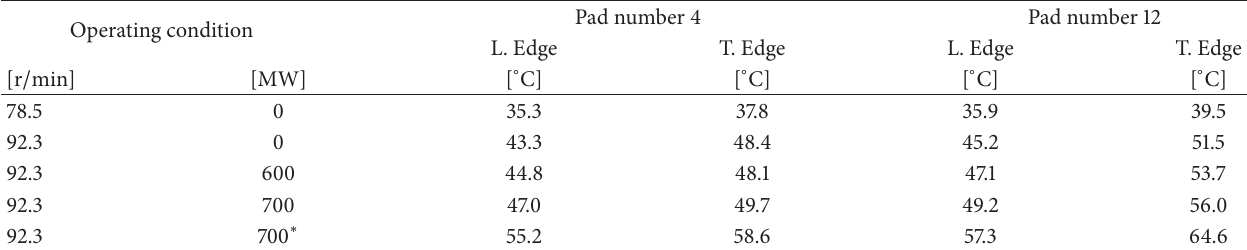
Table 3: Temperatures in the pads of upper journal bearing of a LHG.